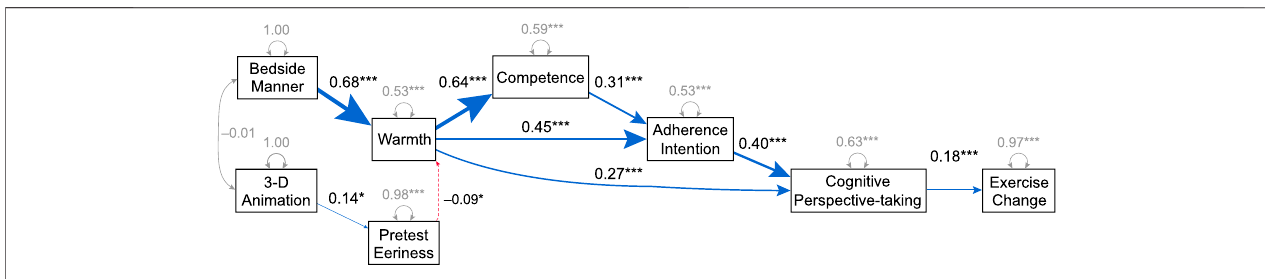
FIGURE 7 | Model 4a: Path model of Exercise Change with SCM variables and pretest Eeriness. Pretest Eeriness was incorporated into Model 4. The model had acceptable local and global fi t ( Table 4 ).